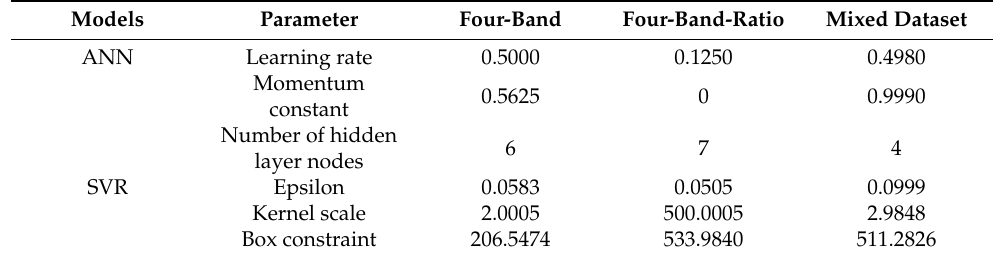
Table 4. Best optimized parameters for the artificial neural network (ANN) and support vector model (SVR)